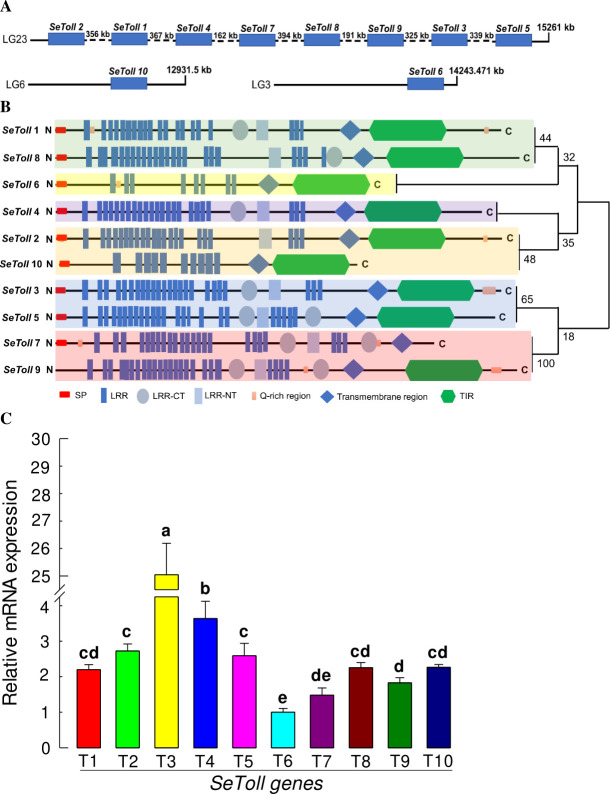
Toll receptors (Se-Tolls) of S. exigua.(A) Gene map of 10 Se-Tolls predicted in this study on chromosome(s), showing three linkage groups (LGs). (B) Their domain and phylogeny analyses. Predicted domains included SP (signal peptide), LRR (leucine-rich-repeat), LRR-CT (leucine-rich-repeat C terminal), LRR-NT (leucine-rich-repeat N terminal), Q-rich region (glutamine rich region), transmembrane region, and TIR (Toll-interleukin receptor). Neighbor-joining method was applied for constructing a phylogenetic tree. Bootstrap values on nodes are obtained from 1,000 repetitions. (C) Expression profile of 10 Toll genes (‘T1-T10’) in naive fat body tissues of S. exigua. Expression level of a ribosomal gene, RL32, was used as reference to normalize expression levels of target genes. Each treatment was replicated three times. Different letters above standard deviation bars denote significant difference among means at Type I error = 0.05 (LSD test).